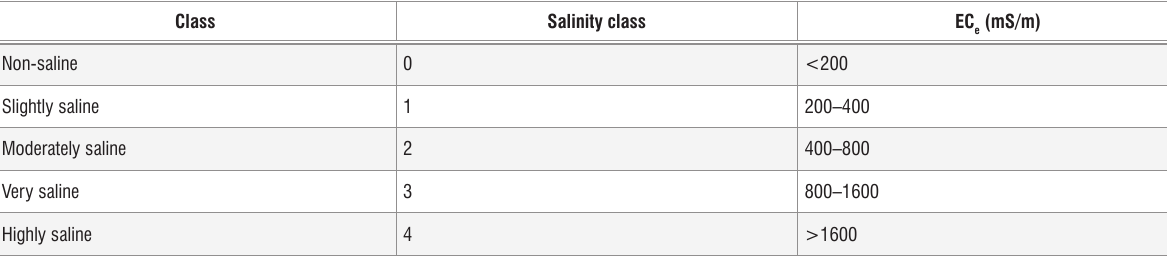
) values of soil salinity classes 21,22 e